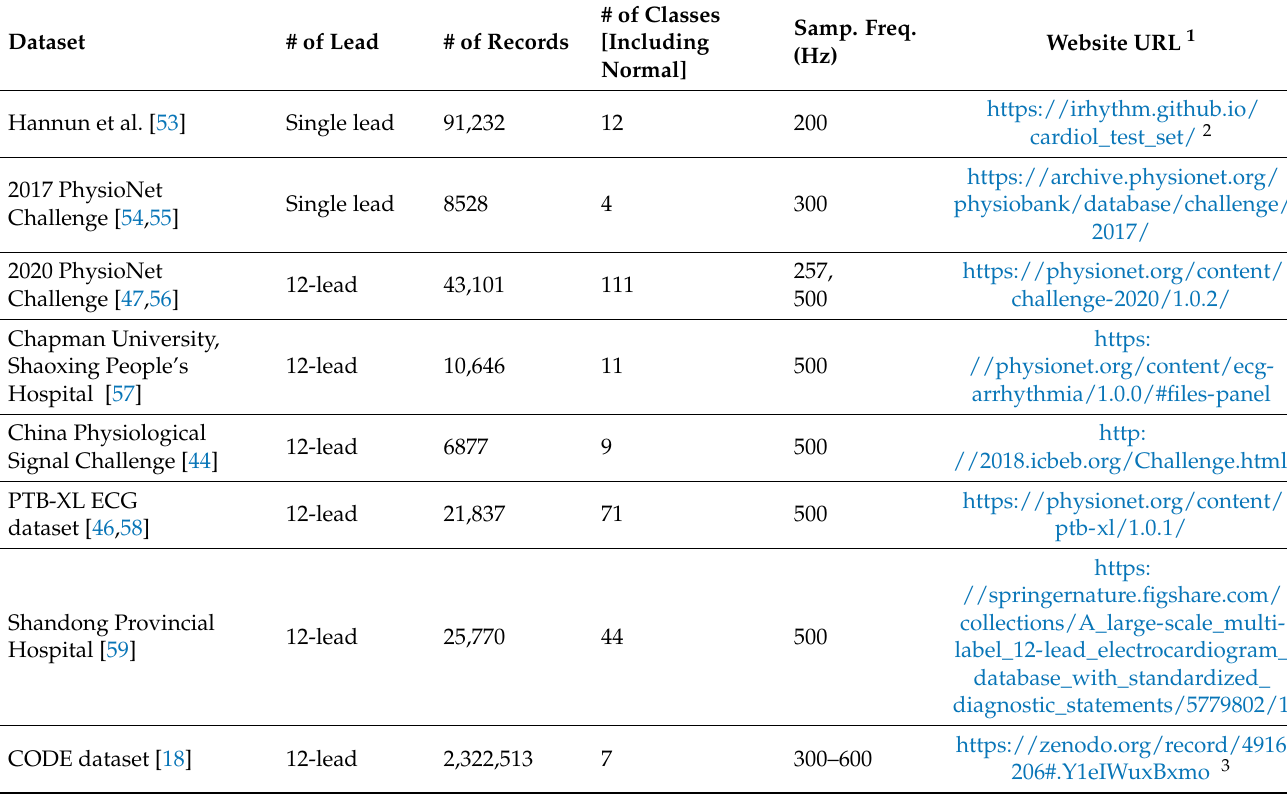
Table 4. Heart ECG signal diagnosis datasets.